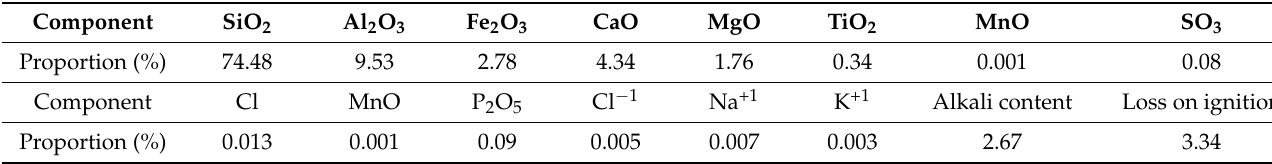
Figure 2. Desert sand and ordinary sand: ( a ) Group A, 0.075–0.3 mm; ( b ) Group B, 0.075–0.3 mm; ( c ) Group C, 0.3–0.6 mm; ( d ) Group D, 0.6–1.18 mm; ( e ) Group E, 0.075–1.18 mm. Table 1. Chemical composition of desert